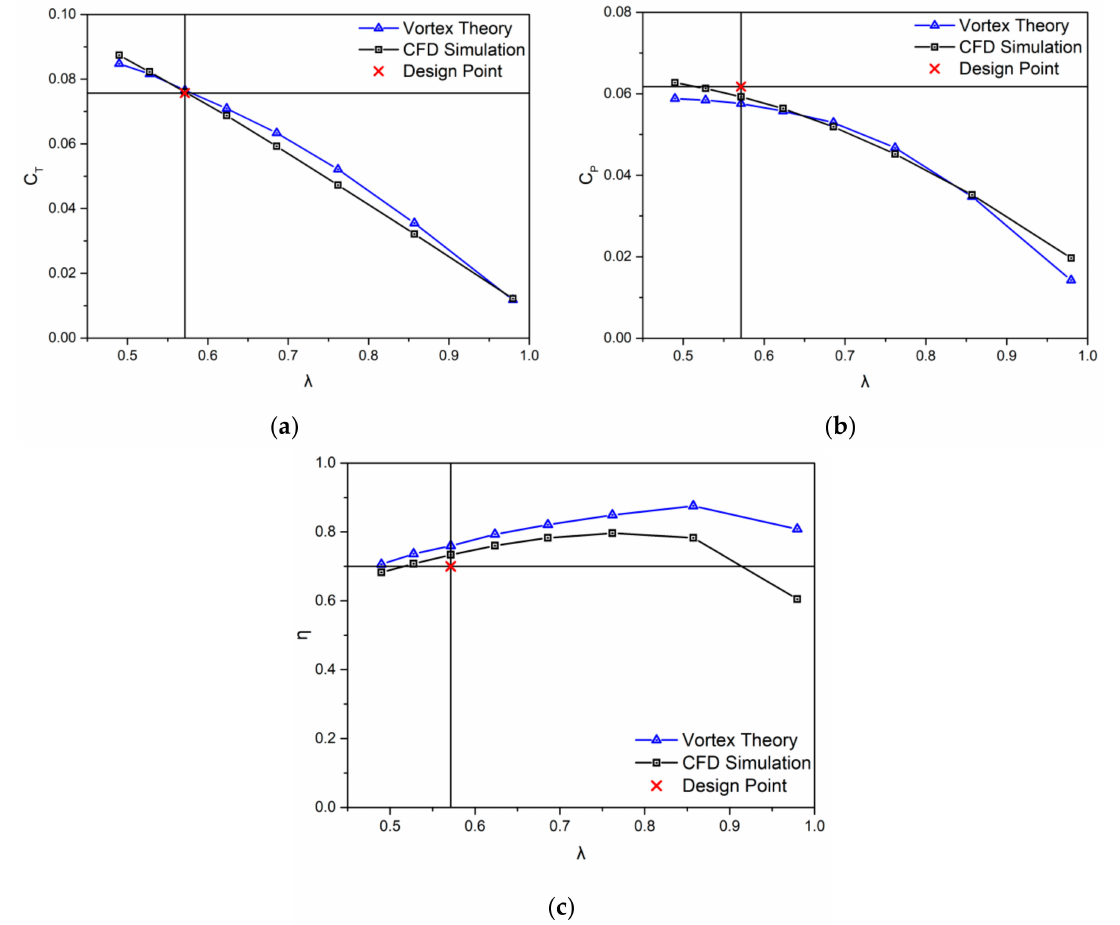
Figure 18. Comparison of the results from vortex theory with those form CFD simulation: ( a ) thrust coefficient; ( b ) power coefficient; ( c )